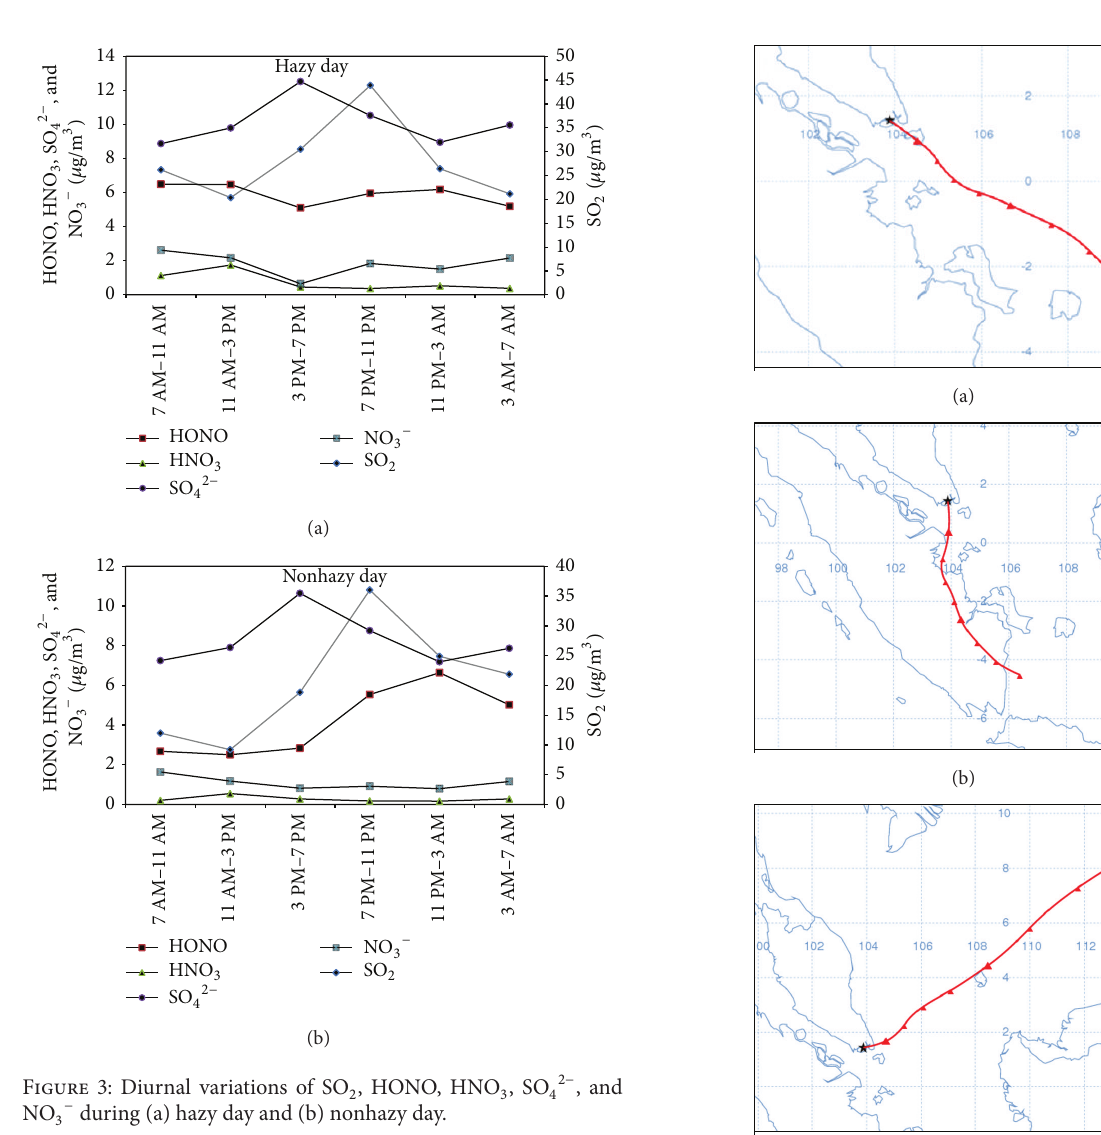
the air parcel with respect to a set of latitudes and